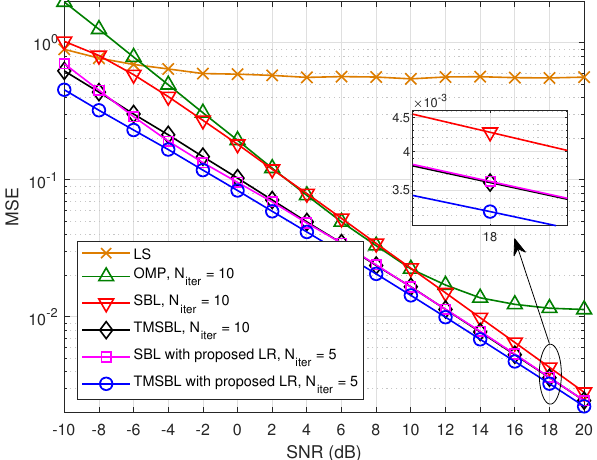
Figure 4. MSE performance versus